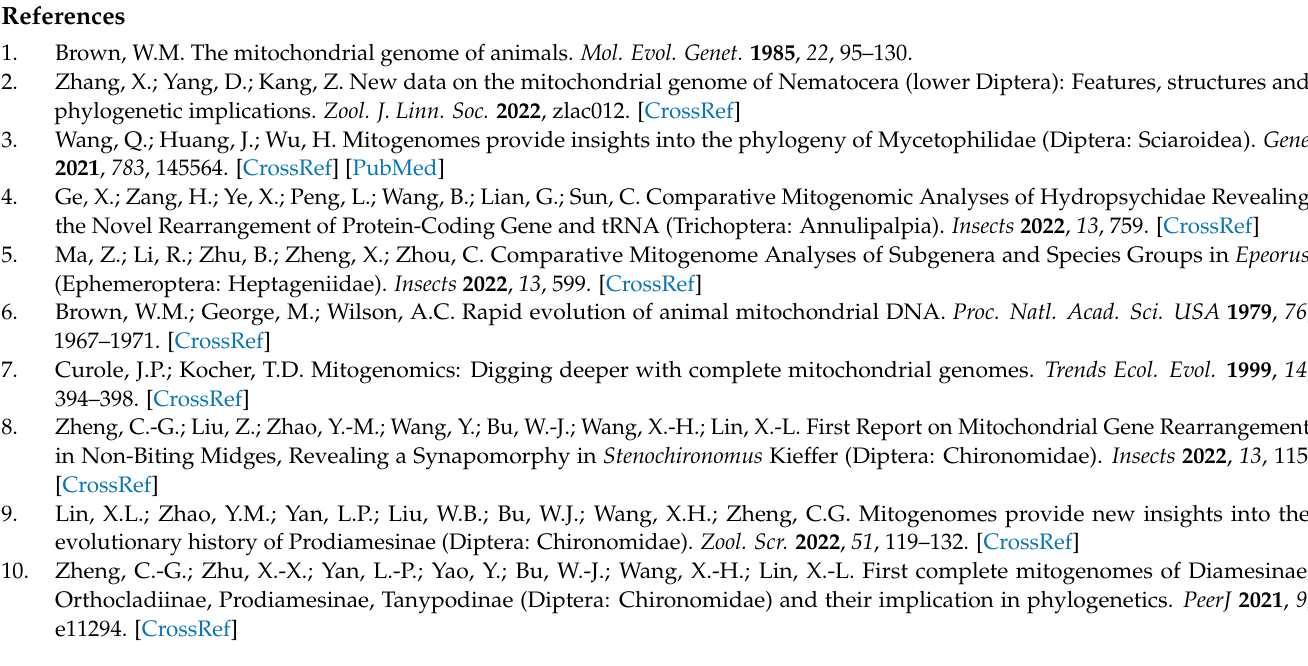
in GTR distance. Figure S2: Phylogenetic trees of Chironomus inferred from the AA dataset. (a) BI tree. Numbers at the nodes are BI posterior probabilities. (b) ML tree. Numbers at the nodes are ML bootstrap values. Figure S3: Phylogenetic trees of Chironomus inferred from the PCG123 dataset. (a) BI tree. Numbers at the nodes are BI posterior probabilities. (b) ML tree based. Numbers at the nodes are ML bootstrap values. Figure S4: Phylogenetic trees of Chironomus inferred from the PCG12R dataset. (a) BI tree. Numbers at the nodes are BI posterior probabilities. (b) ML tree. Numbers at the nodes are ML bootstrap